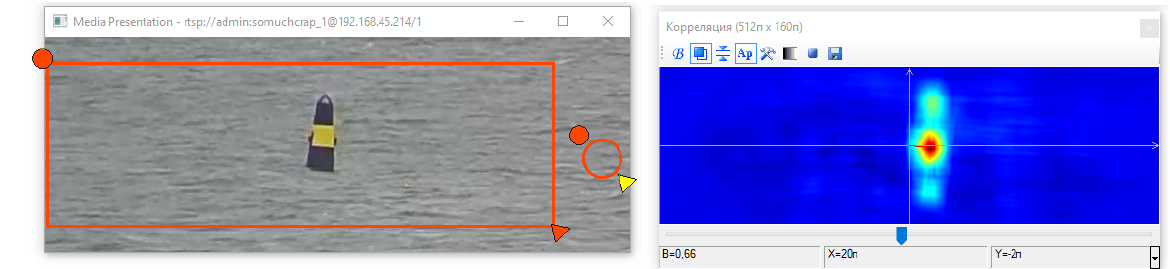
Figure 10. Registration of buoy movements: Correlation tool, Hikvision camera, optical zoom 30×.